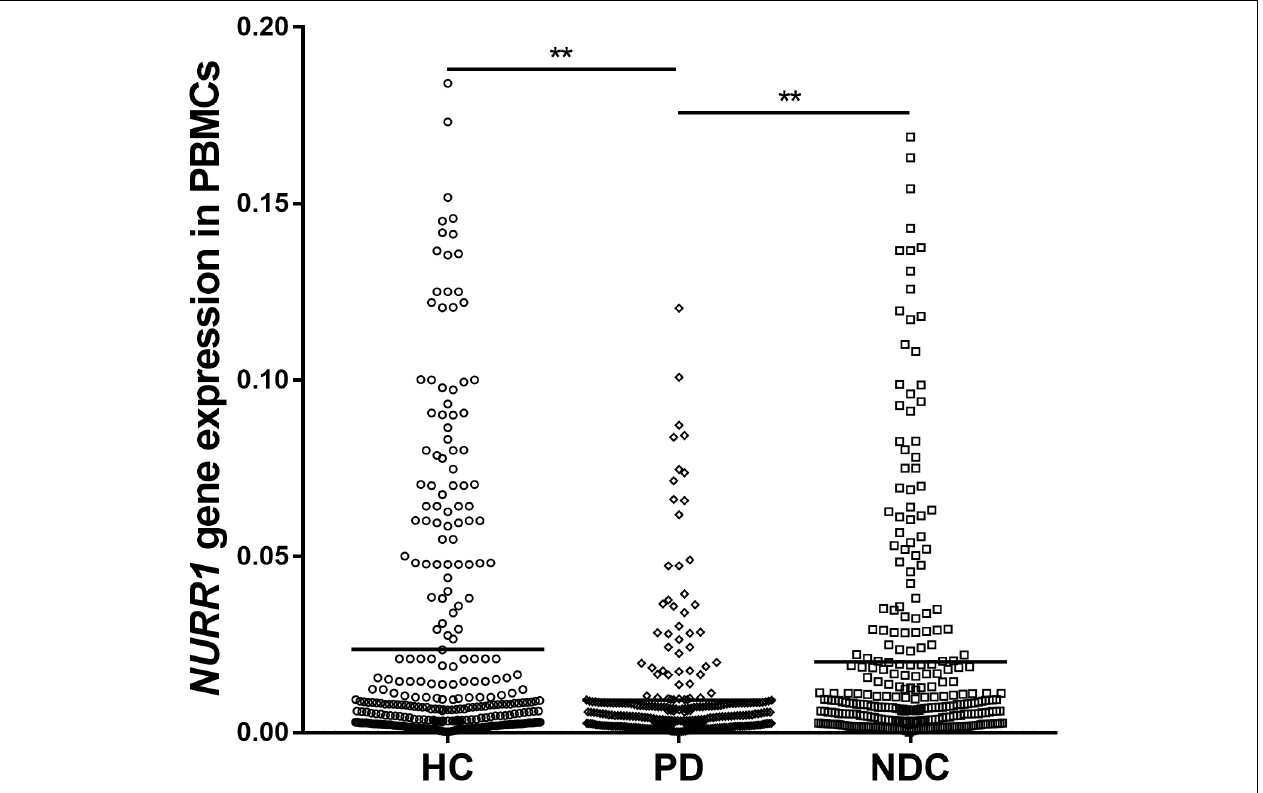
FIGURE 1 | Scatter plots of NURR1 gene relative mRNA expression level in the PBMCs of HC ( n = 318), PD ( n = 312), and NDC ( n = 332), which was determined using real-time PCR assays. Horizontal bars represent mean value. The NURR1 gene mRNA level in the PBMCs was markedly low in patients with PD (mean ± SEM, 0.009 ± 0.0009) as compared with HC (mean ± SEM, 0.023 ± 0.0021) and various NDC (mean ± SEM, 0.019 ± 0.002). ∗∗ p < 0.01.